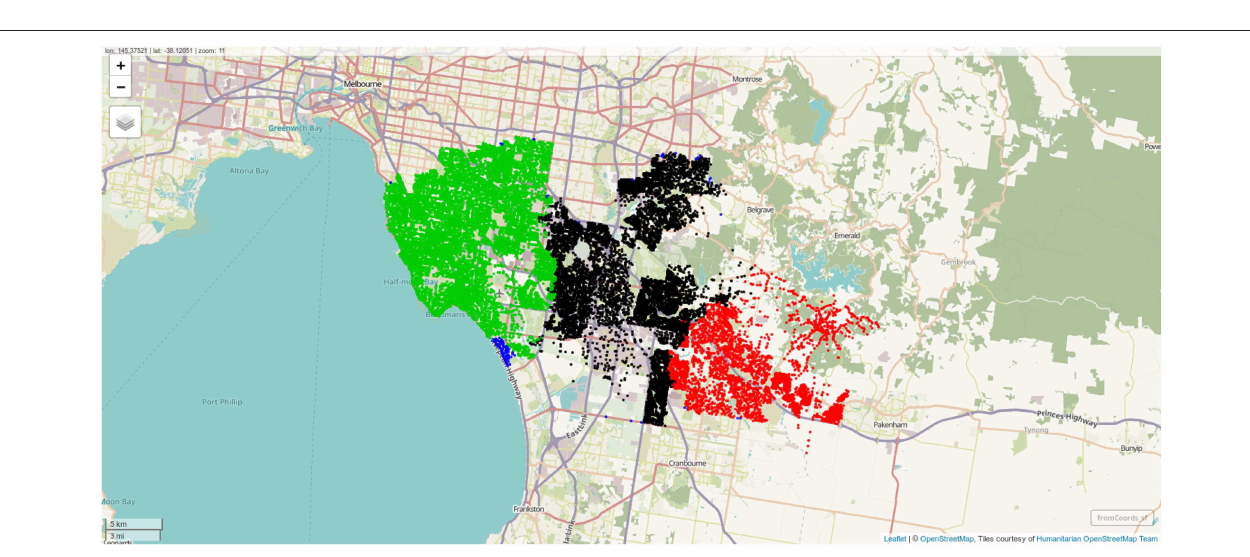
Frontiers in Neurology |